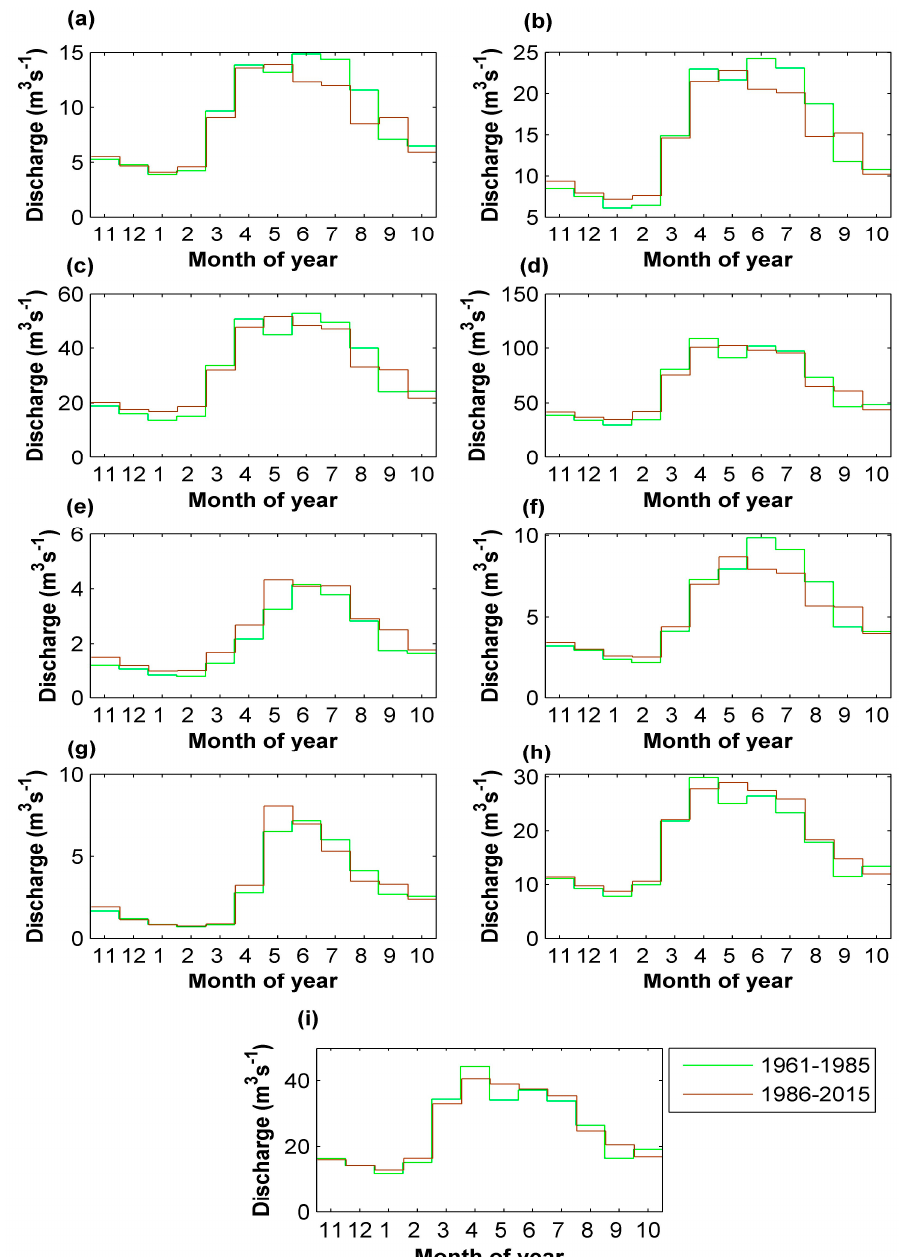
Figure 4. Annual cycle of mean monthly discharge for two subsequent periods at ( a ) Nowy Targ; ( b ) Nowy Targ ‐ Kowaniec; ( c ) Kro ś cienko; ( d ) Nowy S ą cz; ( e ) Zakopane ‐ Harenda; ( f ) Szaflary; ( g ) Ł ysa Polana; ( h ) Muszyna; and ( i ) Stary S ą cz. Between the time periods 1986–2015 and 1961–1985, significant increases in discharge were identified for February, May, and September.